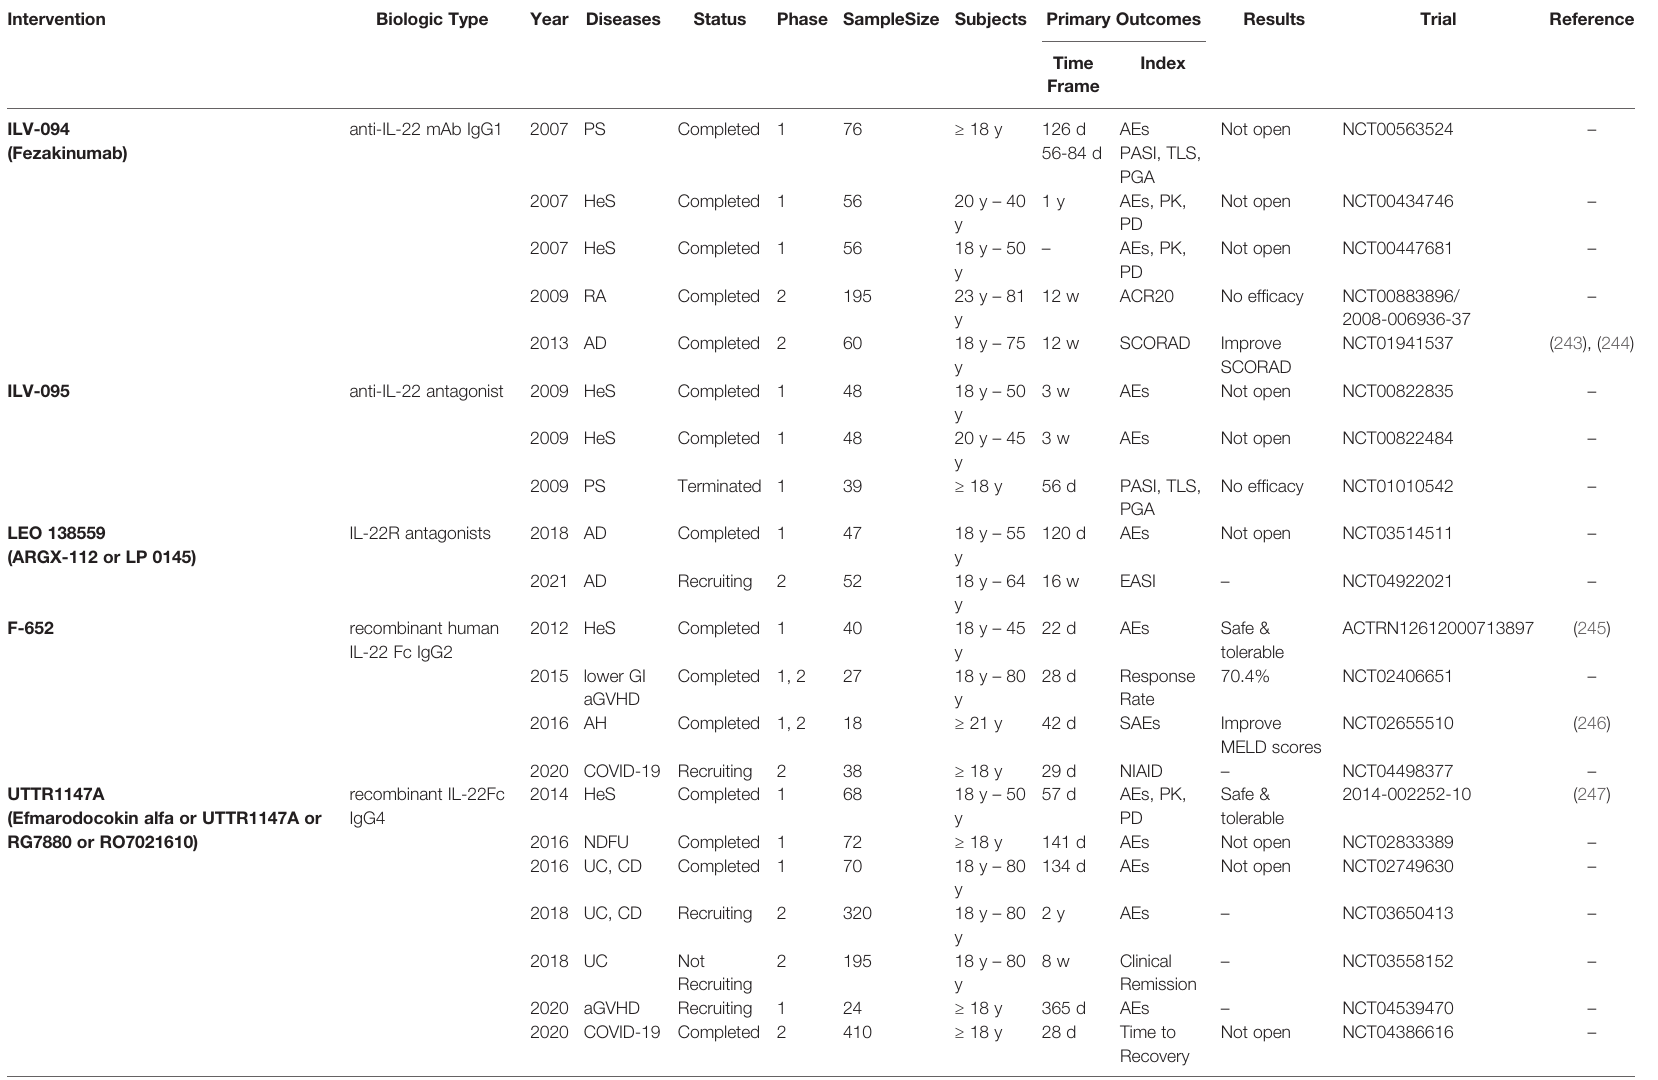
TABLE 1 | Clinical Trials Targeted IL-22 Immune